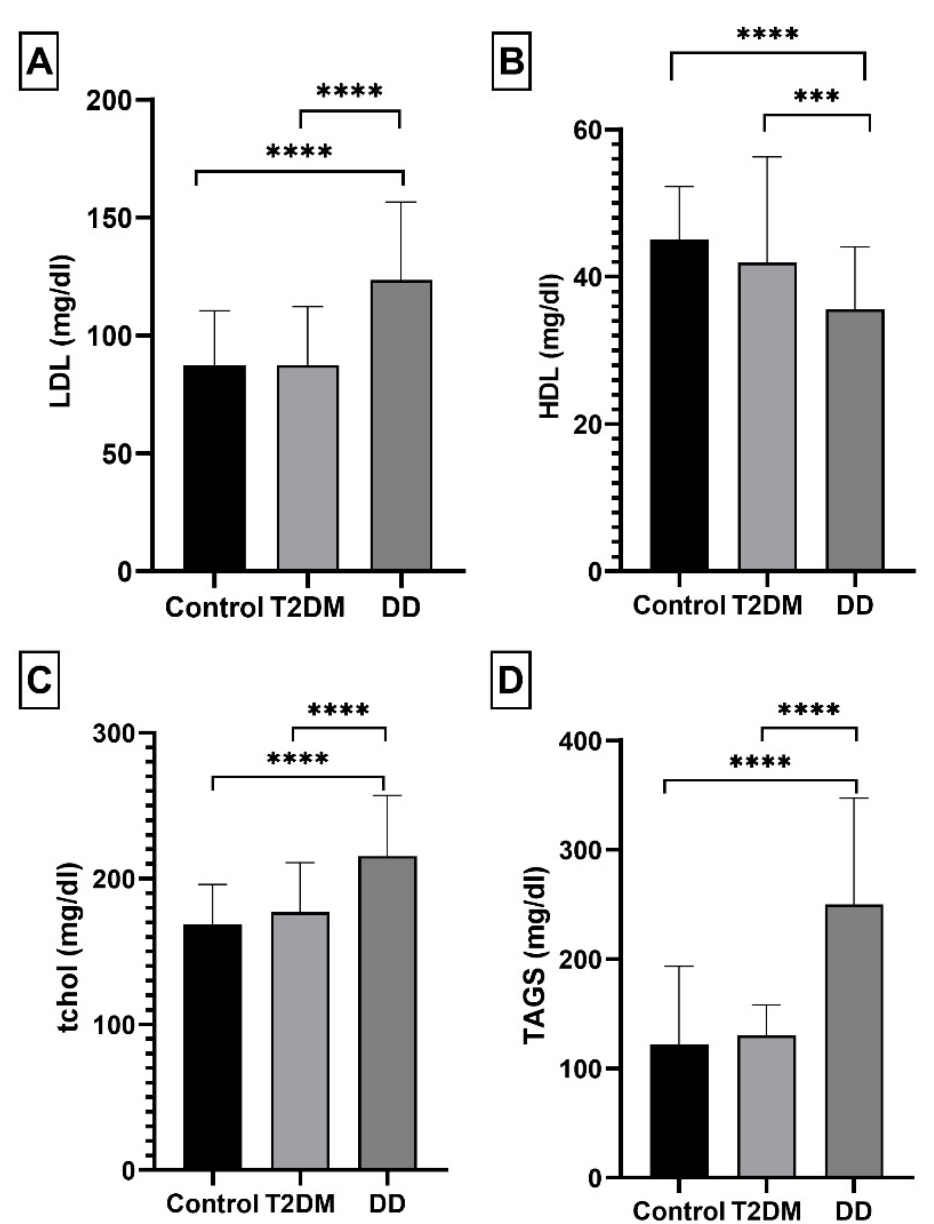
Figure 2. The differences in parameters between the control, T2DM, and DD groups. Each bar represents the group’s mean. Error bars are ± standard deviation Note: T2DM and DD data are compared with the control group. *** and **** denote statistically significant ( p < 0.001; p < 0.0001 respectively). ( A ): Low density lipoprotein (LDL mg/dl); ( B ): High-density lipoprotein (HDL mg/dl); ( C ): Total serum cholesterol (tchol mg/dl); ( D ): Serum triglycerides (TAGS mg/dl).